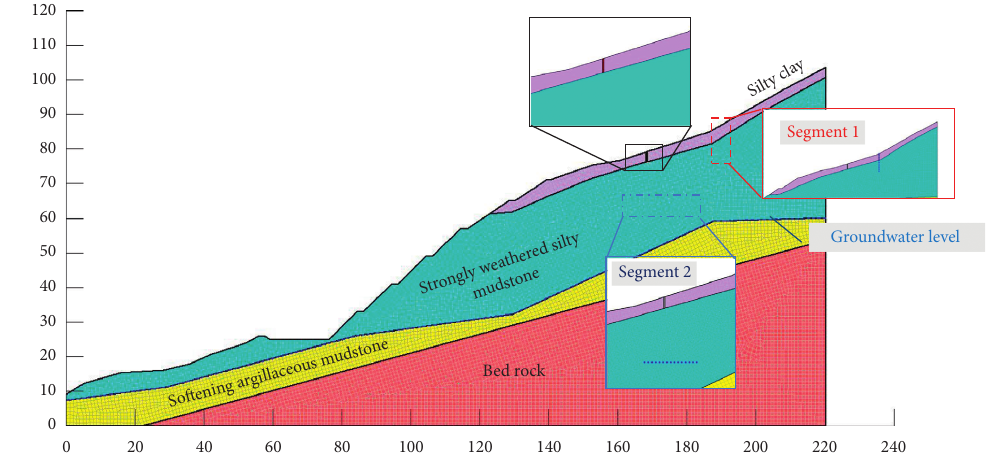
Figure 6: Numerical model of the studied slope.